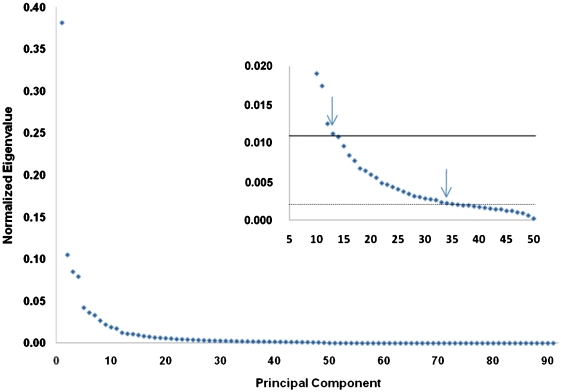
Scree plot showing the fraction of variance accounted for by each PC.The main graph shows discontinuities after the first, fourth and eleventh PC. The insert displays the subspace between the tenth and the fiftieth PC, illustrating the ‘bootstrapped’ Kaiser-Guttman criterion. The solid, upper line shows the average of normalized eigenvalues, defining PC 13 as the critical component (left arrow), and the dashed line the inferior 95% confidence interval which indicates the component retention down to PC 34 (right arrow).